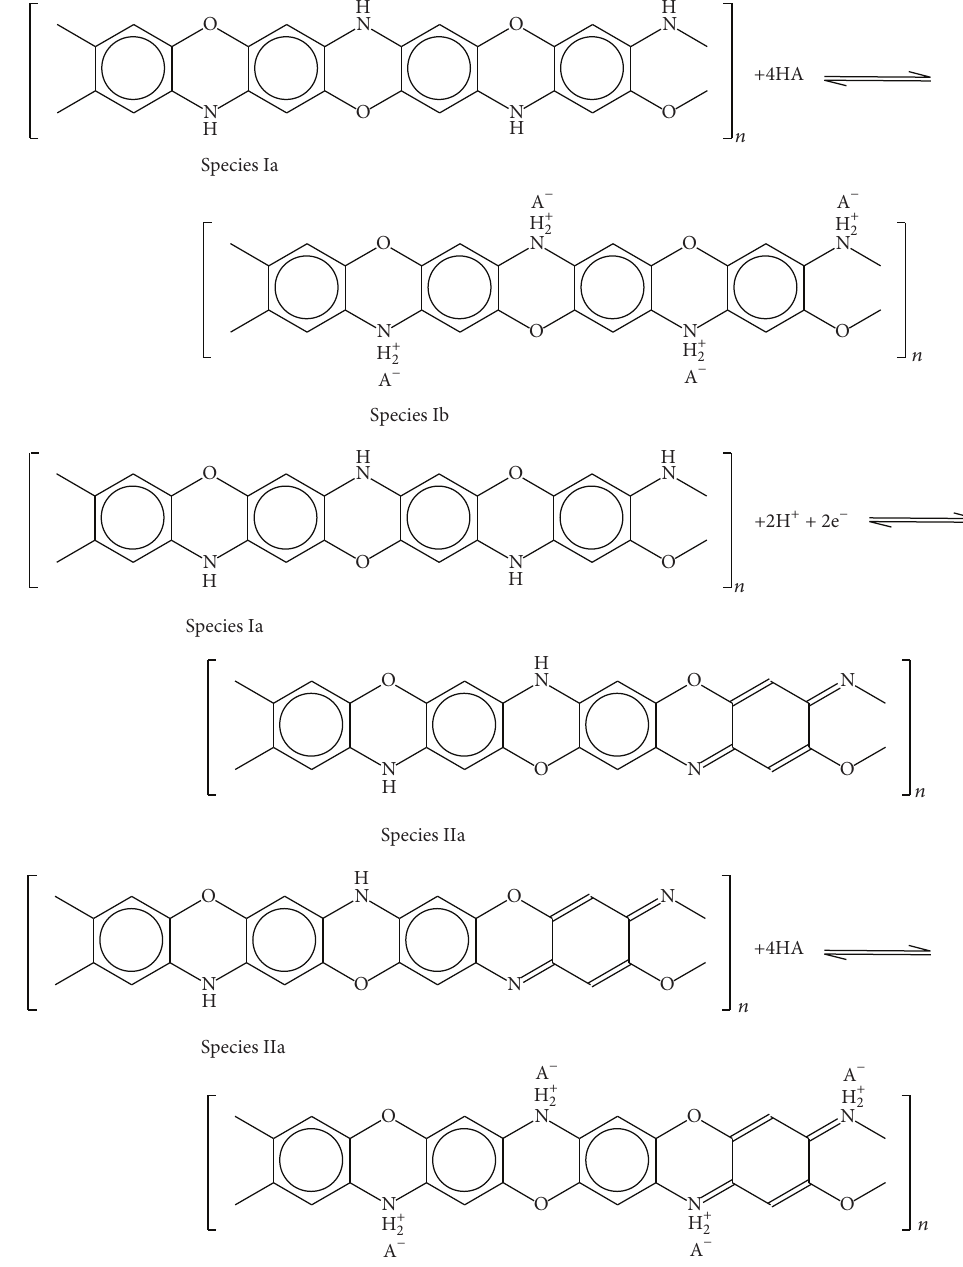
F 16: Reaction scheme of the POAP redox switching proposed in [6, 14, 57] including the protonation equilibria of the oxidized (species II) and reduced (species I)